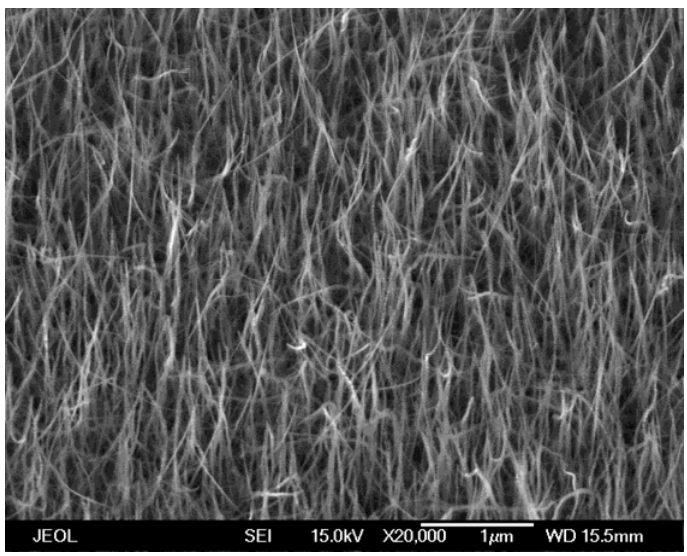
Figure 1. SEM image of ZnO multiple